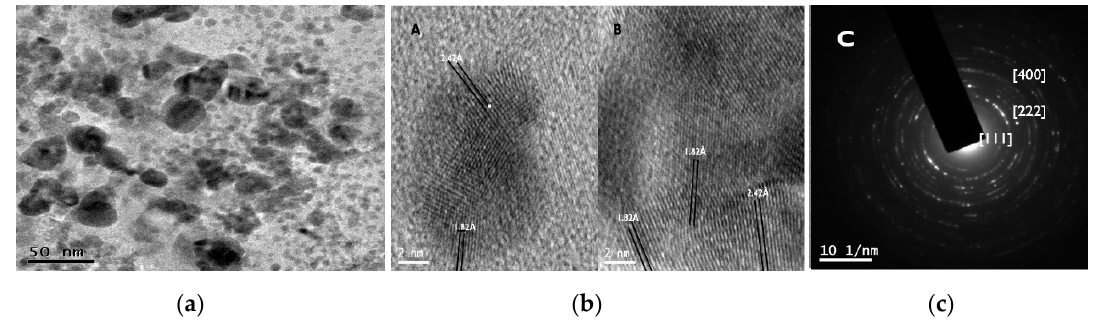
Figure 1. Micrograph of the composite ( a ), high resolution micrograph of the composite ( b ), and diffraction pattern of the composite ( c ).